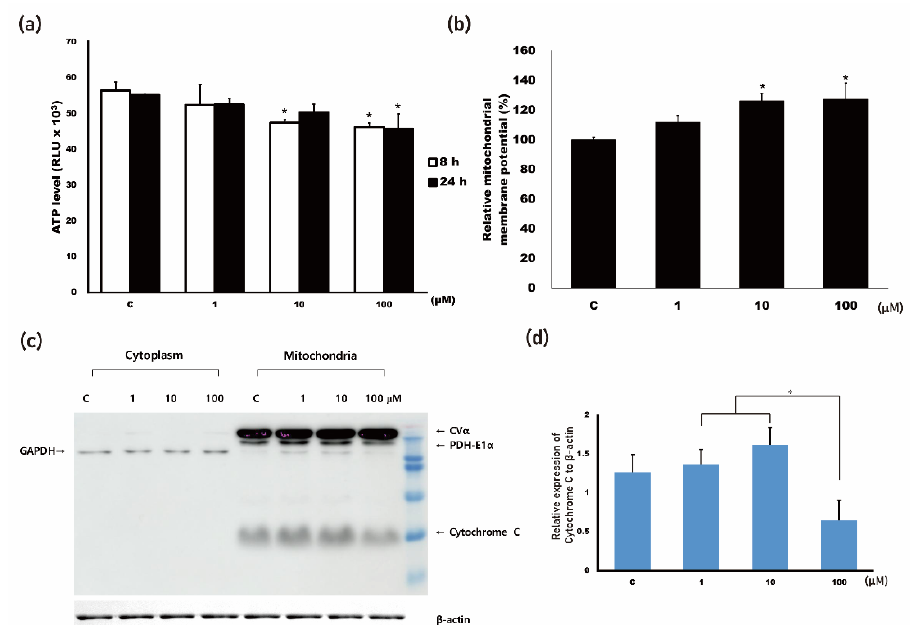
Figure 1. ATP and mitochondrial membrane potential (MMP) assay. ( a ) Administration of 4HR slightly decreased the ATP levels in HUVECs (* p < 0.05 compared to the control group; RLU, relative light units). ( b ) MMP was slightly increased by 4HR administration in HUVECs. In the case of 10 and 100 µ M 4HR administration, MMP was increased by approximately 20 % compared to the untreated control (* p < 0.05). ( c ) Administration of 4HR (100 µ M) decreased the cytochrome c level in the mitochondrial fraction in HUVECs. However, cytoplasmic leakage of mitochondrial cytochrome c was not clearly detected in the cytoplasmic fraction. ( d ) Cytochrome c level relative to mitochondrial β -actin was calculated and compared. There was no significant difference in the cytochrome c level of the mitochondria among the untreated control and the 1 and 10 µ M 4HR administration groups ( p > 0.05). In the case of 100 µ M 4HR administration, the cytochrome c level of the mitochondria was decreased significantly compared to the untreated control and the 10 µ M 4HR administration group (* p <